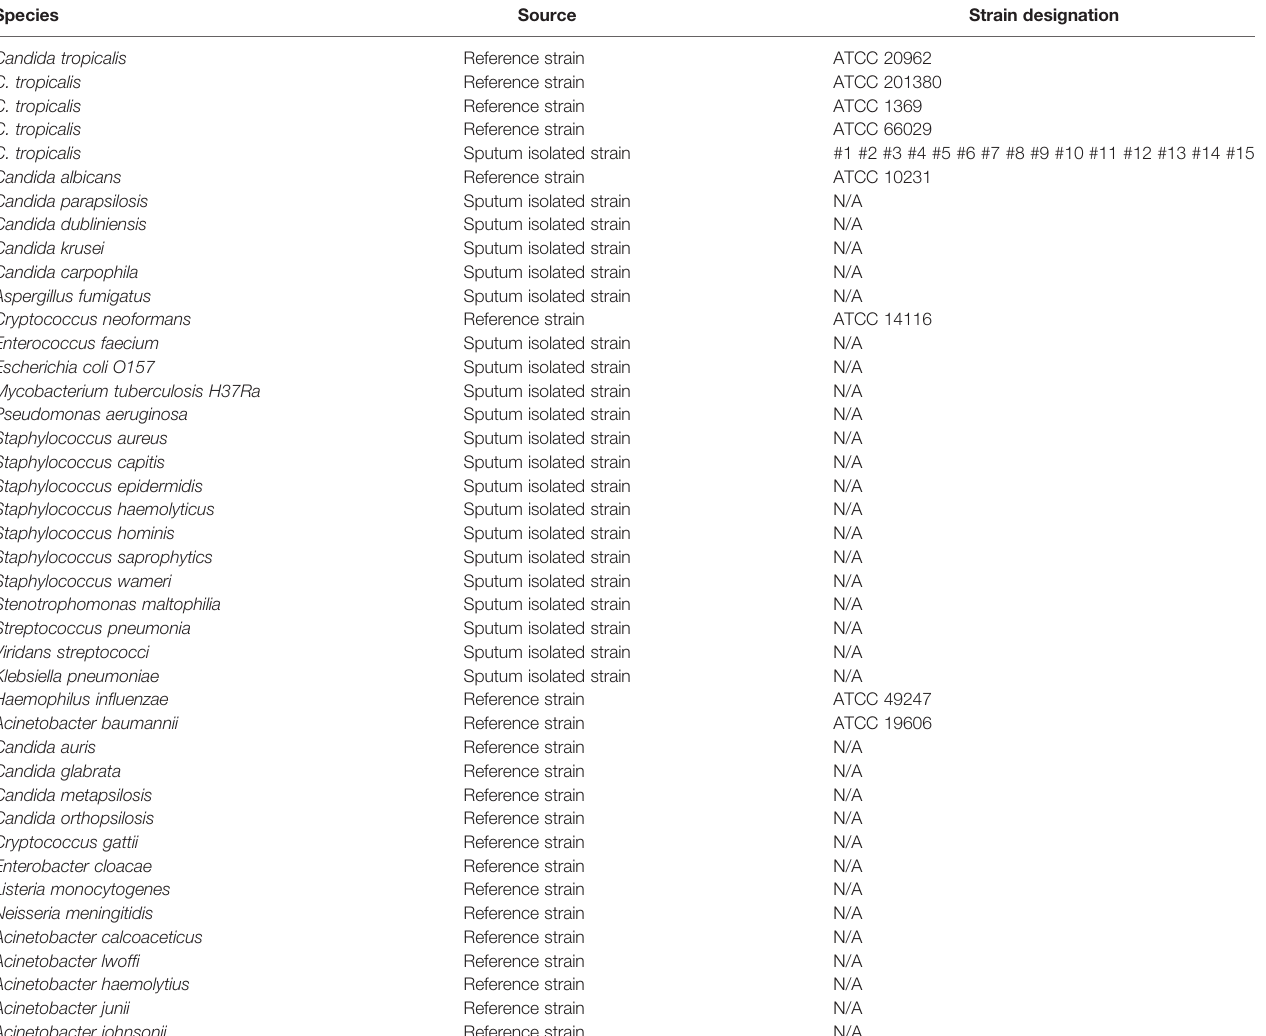
TABLE 2 | Bacterial strains used in this study. Species